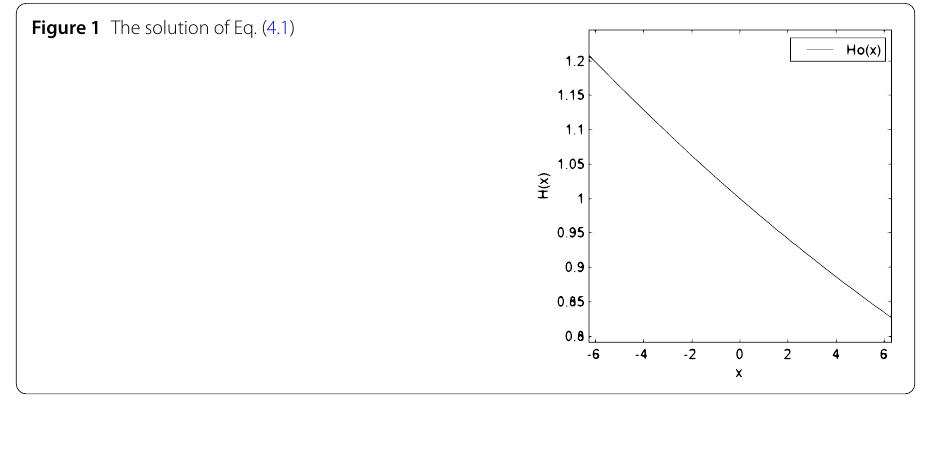
Figure 1 The solution of Eq.